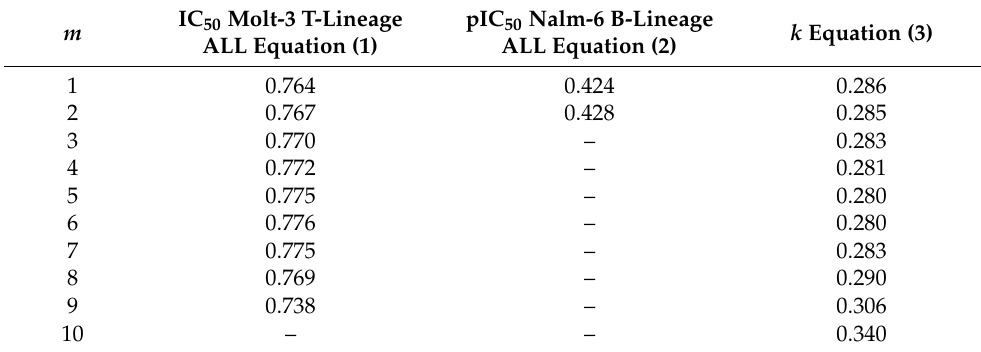
Table 4. Cross-validated correlation coefficient in leave -m- out for Cys diazomethyl- and chloro- methylketones.